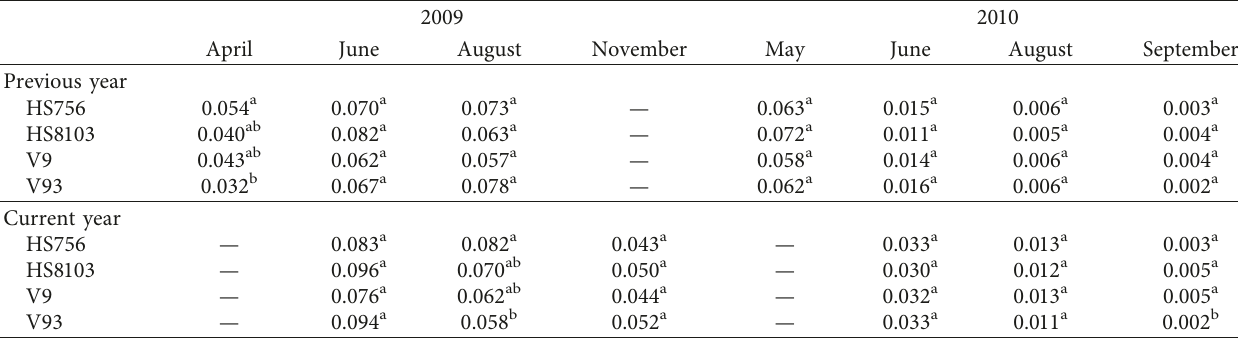
Table 3: Stomatal conductance ( g · m − 2 · s − 1 ) of previous- and current-year foliage of loblolly pine genotypes at a site in North Central s ; mmol Louisiana in 2009 (temperate year) and 2010 (droughty